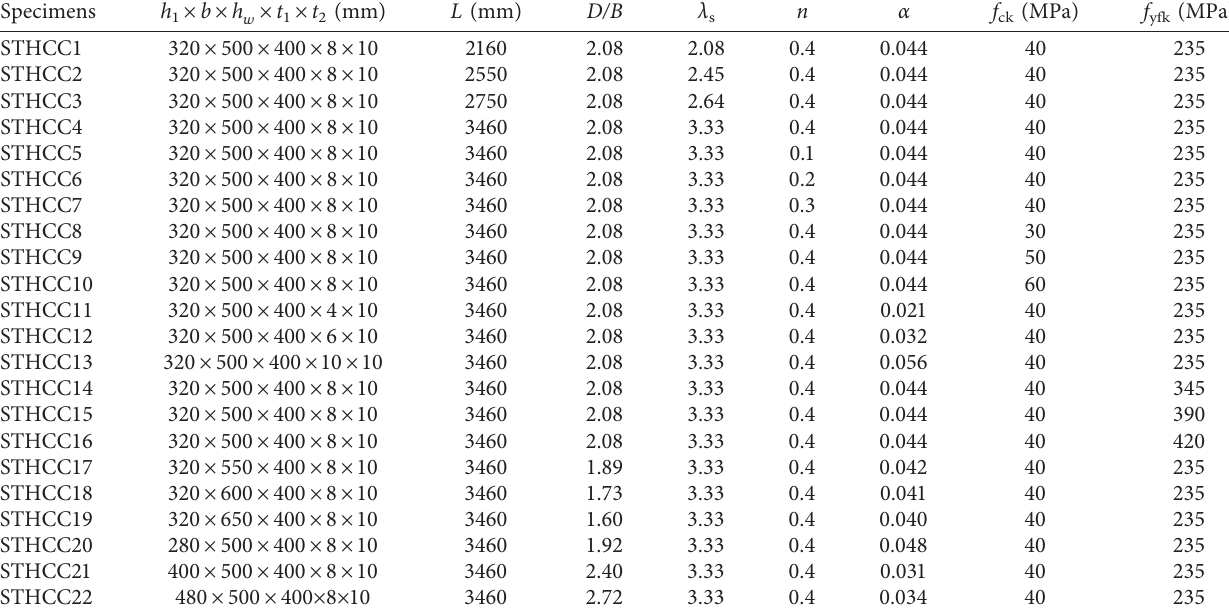
Figure 1: The three-dimensional model of STHCCs. (a) Three-dimensional model. (b) Longitudinal section of STHCCs. (c) Cross section of STHCCs. Table 1: Specific parameters of 22 STHCC